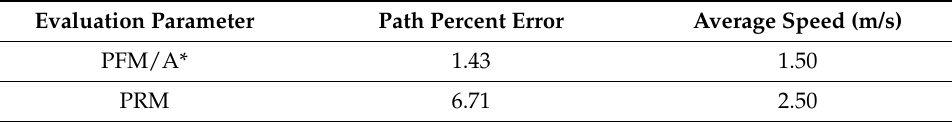
Figure 23. Case Study III simulated path output. Table 11. Summary of simulated performance values for Case Study